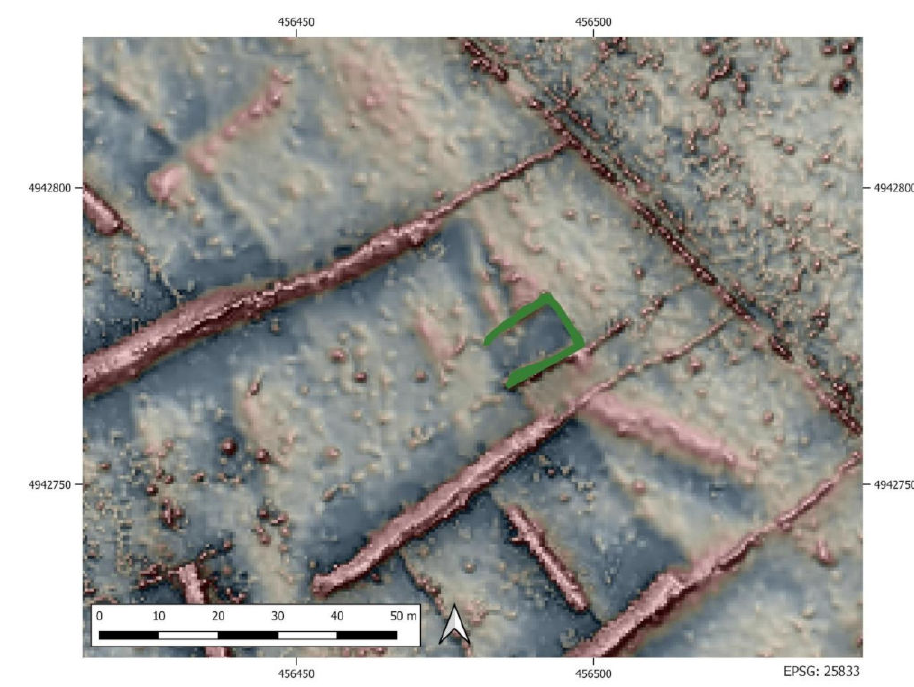
Figure 34. The green structure outlines the rectangular enclosure—see text for further detail (visual- ization: LRM(20) and